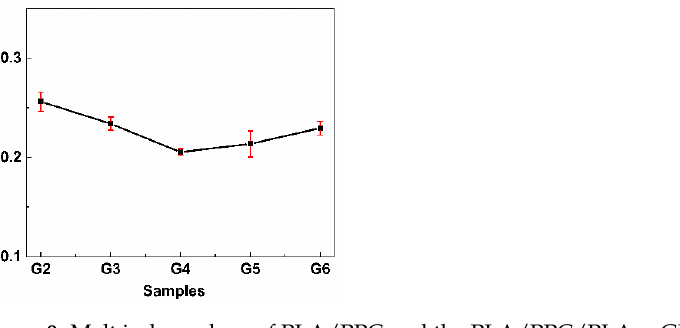
Figure 9. Melt index values of PLA/PPC and the PLA/PPC/PLA-g-GMA blends. (G2: PLA/PPC; G3: PLA/PPC/PLA-g-GMA; G4: PLA/PPC/PLA-g-GMA/St; G5: PLA/PPC/PLA-g-GMA/AMS; G6: PLA/PPC/PLA-g-GMA/EP).